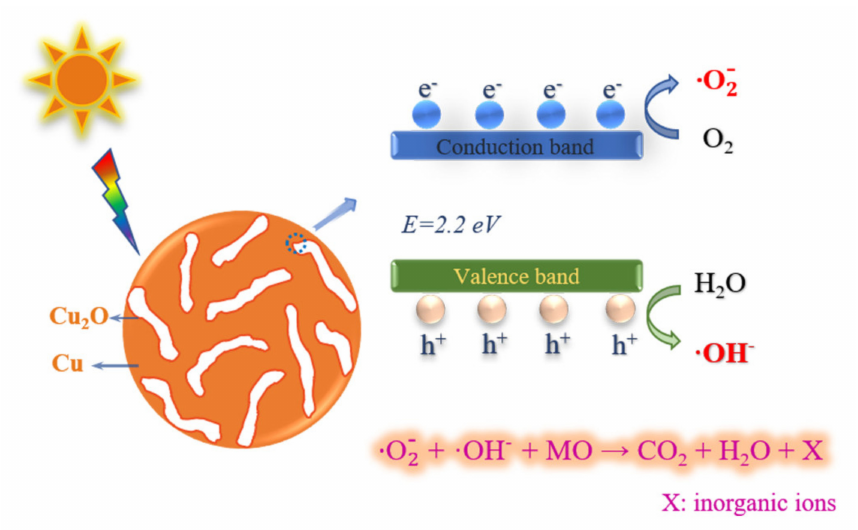
Figure 9. The schematic illustration of the photodegradation mechanism of nanoporous Cu/Cu 2 O in MO